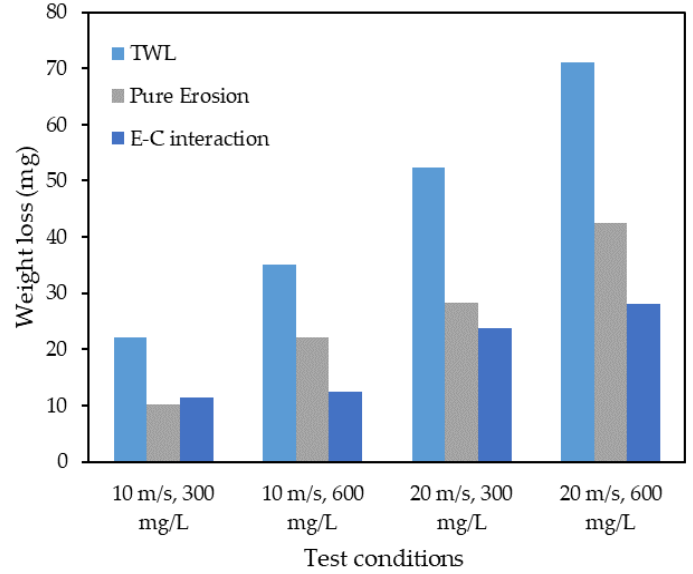
Figure 13. The result of experiments conducted at four different combinations.